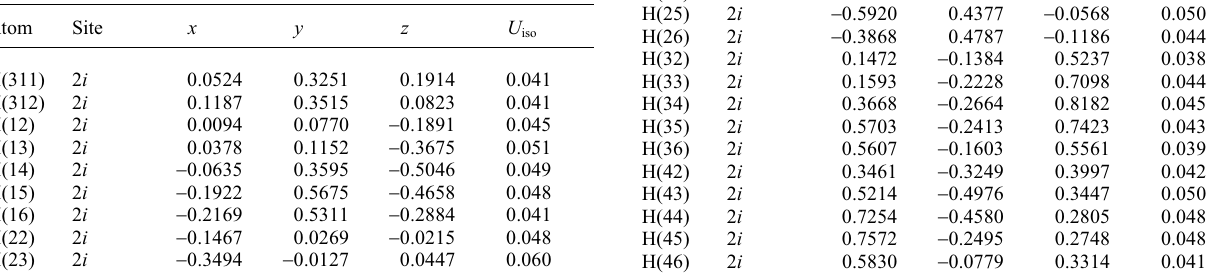
Table 2. Atomic coordinates and displacement parameters (in Å 2 ) .